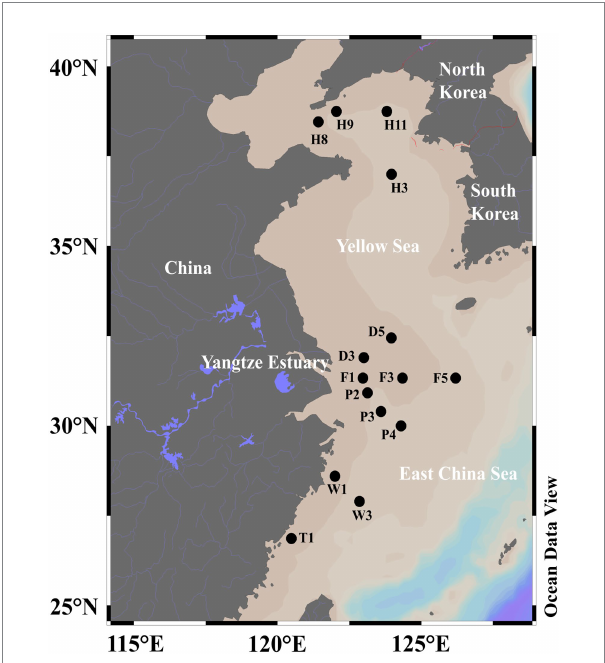
FIGURE 1 The sampling sites of SML and SSW in the eastern China marginal seas in